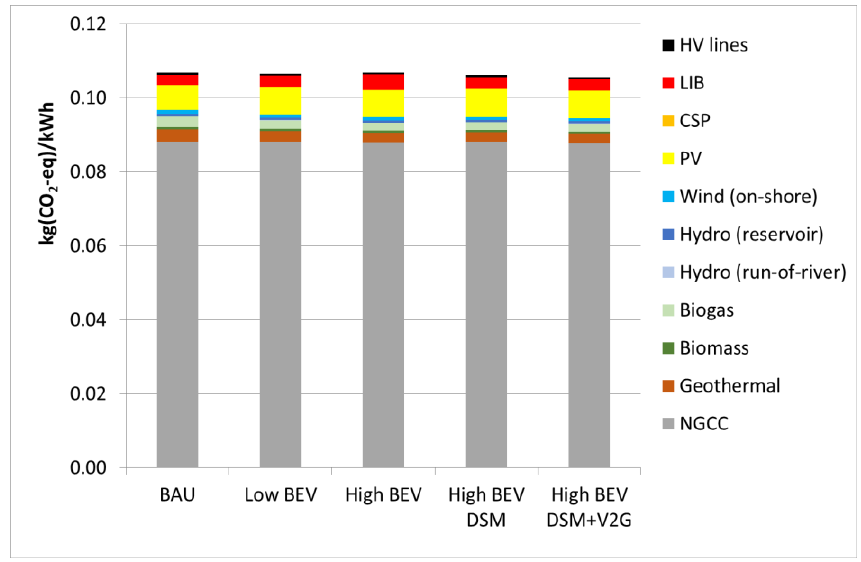
Figure 6. Global warming potential (GWP) of 1kWh of electricity supplied by the domestic grid, with contributions by technology.